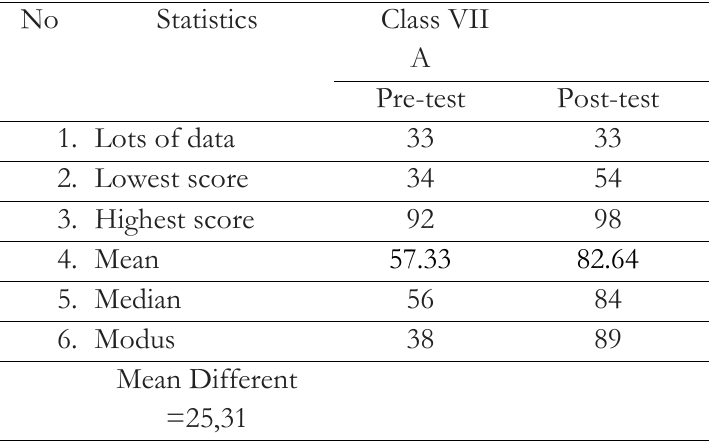
TABLE 1 Respondents' Assessment of Pre-test and Post-test Experimental